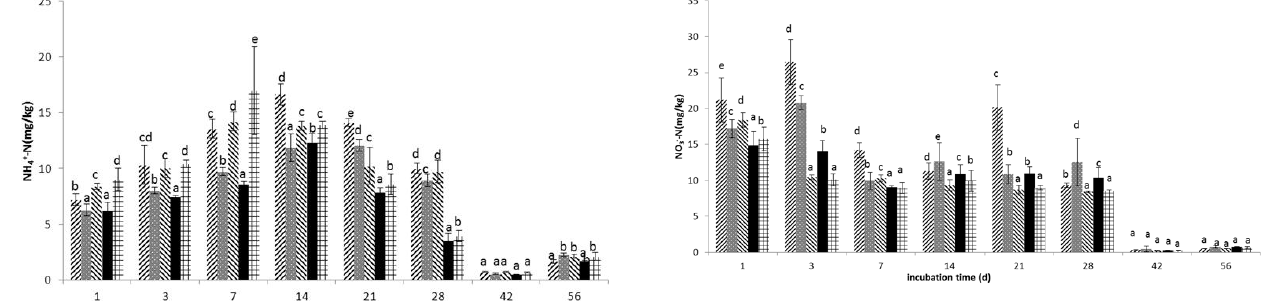
Table 2 Change of inorganic N and available P in leaching solution 3 Fig. 1 Effects of the added furfural and biochar on soil pH. CK; C1: soil added with 2.5% 4 -N 3 biochar; Fig. 2 Effects of the added furfural and biochar on soil EC. CK; C1: soil added with 2.5% 8 Fig. 3 Effects of the added furfural and biochar on soil organic matter contents. CK; C1: soil 12 Fig. 4 Effects of the added furfural and biochar on soil CEC. CK; C1: soil added with 2.5% 16 Fig. 5 Effects of the added furfural and biochar on soil exchange ESP. CK; C1: soil 20 Fig. 6 Effects of the added furfural and biochar on soil available P contents. CK; C1: soil 24 Fig.7 Effects of the added furfural and biochar on soil NH 4+ -N contents. CK; C1: soil 28 Fig. 8 Effects of the added furfural and biochar on soil NO 3- -N contents. CK; C1: soil added 32